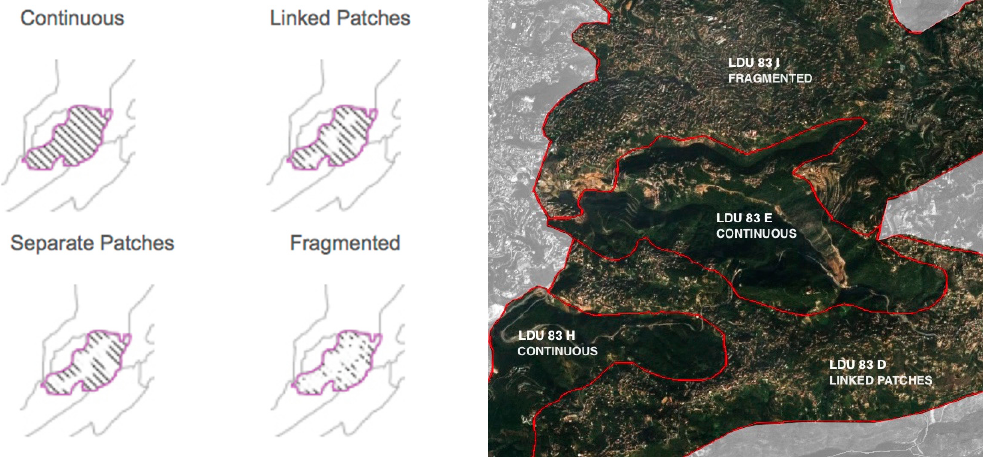
Figure 5. Habitat Continuity assessment per LDUs.